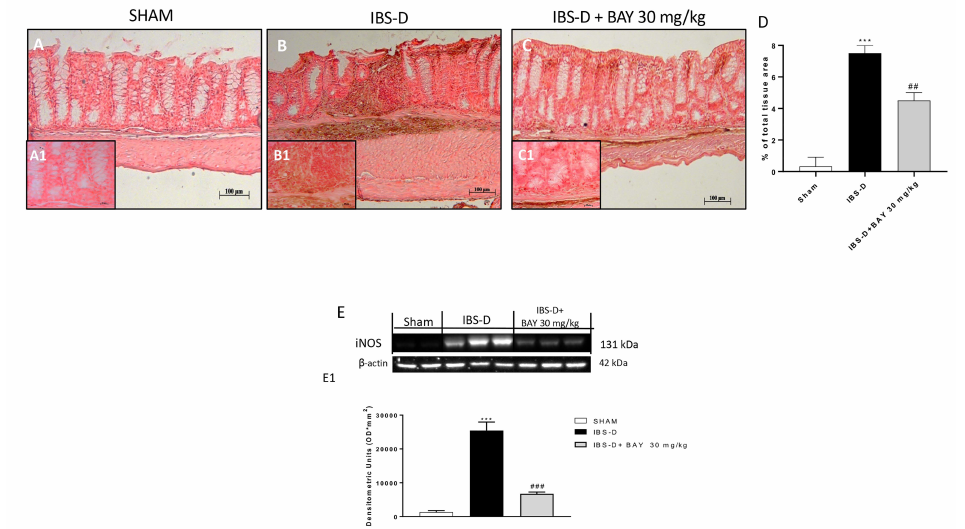
Figure 7. E ff ect of BAY 11-7082 treatment on iNOS expression. Immunohistochemical analysis revealed an increase of the iNOS level in the IBS-D group ( B ) compared to the sham group ( A ). Moreover, BAY treatment 30 mg / kg significantly decreased iNOS levels ( C ). Data were confirmed by Western blot analysis, showing a decrease of iNOS levels in the IBS-D group following BAY treatment 30 mg / kg. Data are representative of at least three independent experiments. ( D ) *** p < 0.001 vs. Sham. ## p < 0.01 vs. IBS-D. ( E ) *** p < 0.001 vs. Sham. ### p < 0.001 vs.